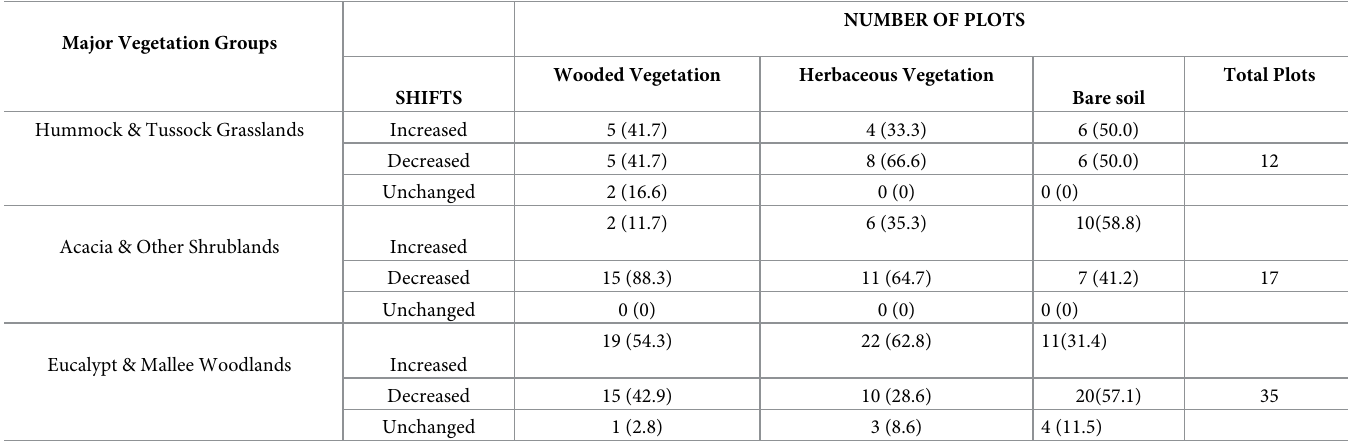
association with time between surveys which was stronger for the herbaceous Hummock and Tussock Grasslands than for Shrublands and Woodlands. Tussock Grasslands displayed the fastest shifts. This response was possibly related to the mostly shorter life spans and shallower roots of grasses and forbs that are more vulnerable to years of drought that occurred Table 2. Number of plots with shifting wooded, herbaceous, or bare soil cover (%).